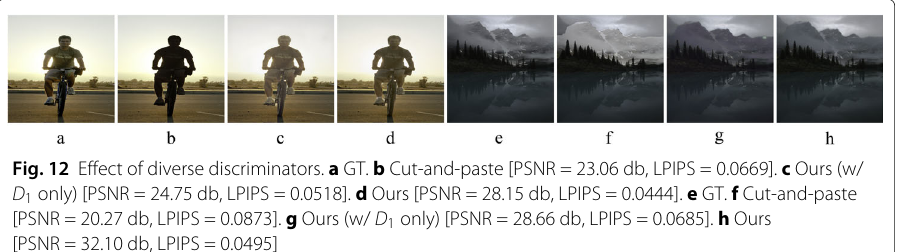
Fig. 12 Effect of diverse discriminators. a GT. b Cut-and-paste [PSNR = 23.06 db, LPIPS = 0.0669]. c Ours (w/ D 1 only) [PSNR = 24.75 db, LPIPS = 0.0518]. d Ours [PSNR = 28.15 db, LPIPS = 0.0444]. e GT. f Cut-and-paste [PSNR = 20.27 db, LPIPS = 0.0873]. g Ours (w/ D 1 only) [PSNR = 28.66 db, LPIPS = 0.0685]. h